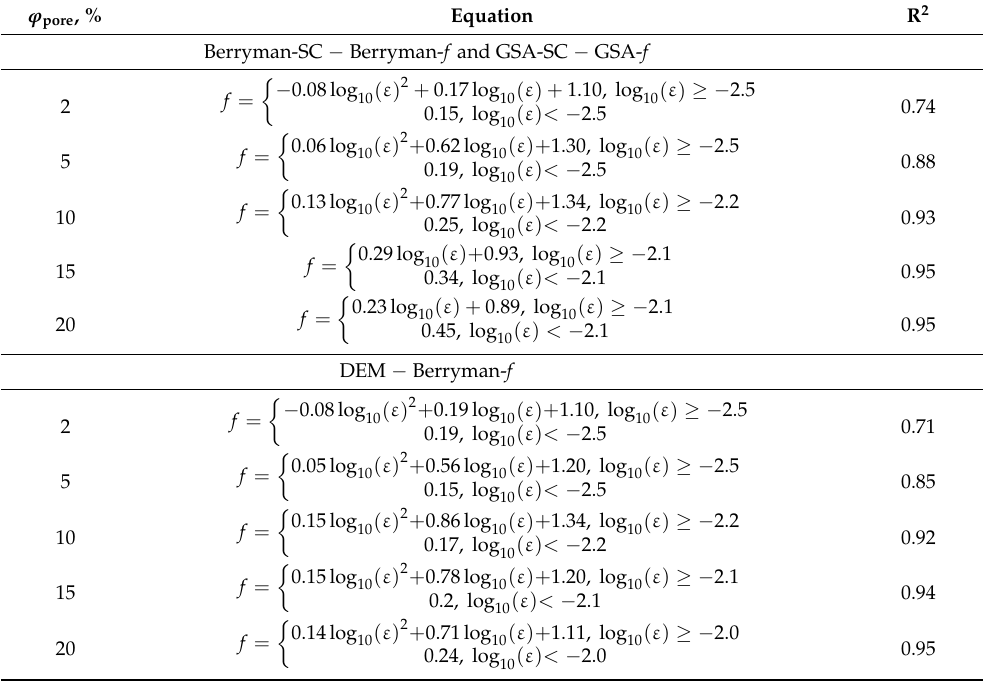
Table 1. Relationships between the crack density and f -parameter for fixed spherical porosity values for the case of brine-saturated voids. The R 2 is the coefficient of determination.